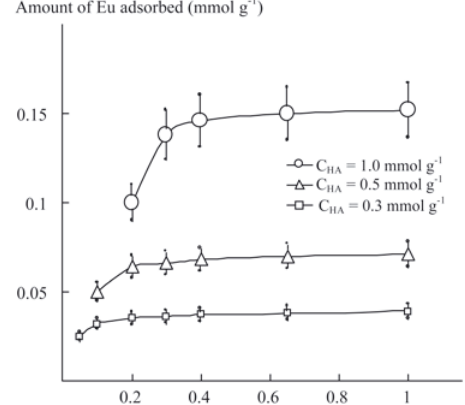
Figure 5. Adsorption isotherms of Eu(III) adsorbed by the FB-D2EHPA sorbent. (FB-D2EHPA dosage: 0.02 g per 10 mL; initial HNO concentration: 0.002 M).